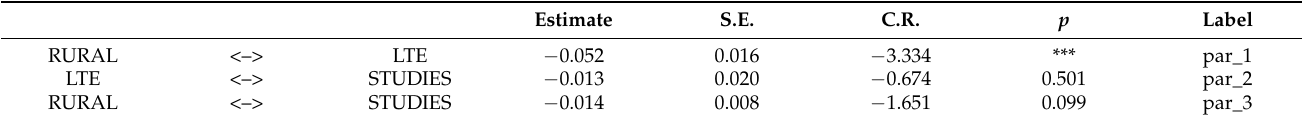
Table A18. Covariances: (Group number 1-Default model).